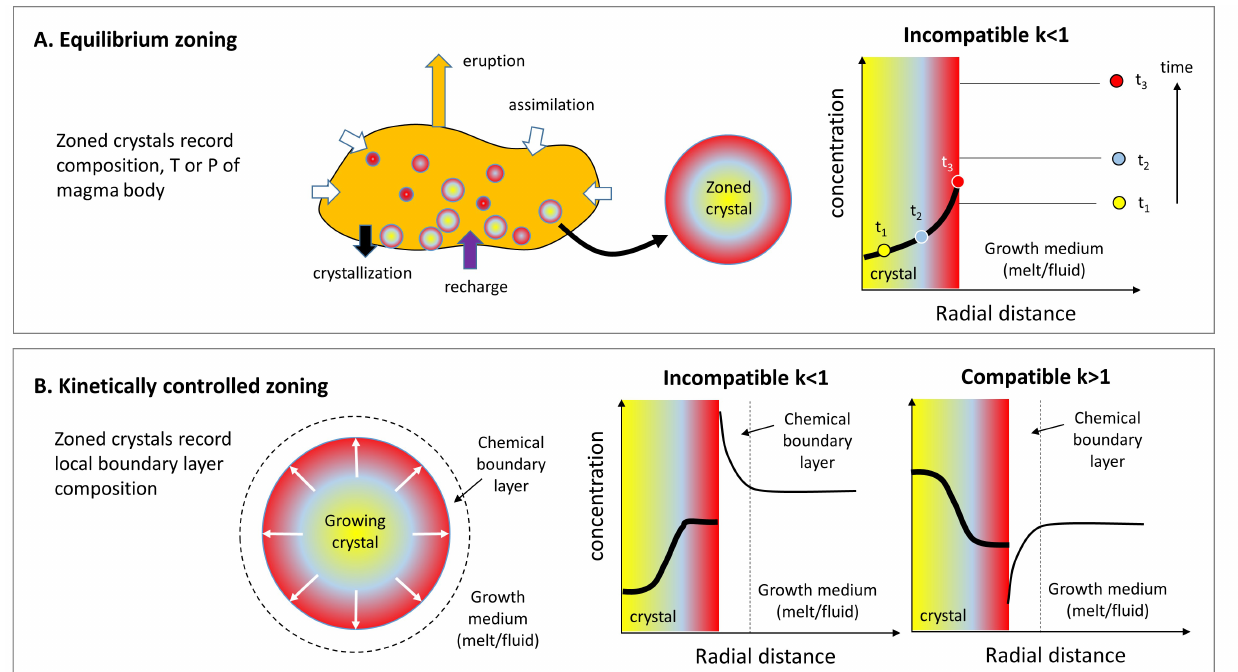
Figure 1: [A] Equilibrium mineral zoning wherein zoning reflects changes in temperature, pressure, or the far-field magma com- position due to fractional crystallization, recharge or mixing. Cartoon magma chamber and zoomed in schematic of a zoned crystal are shown. Right hand plot shows concentration versus radial distance in a crystal for an incompatible element ( k < 1). Left side of plot represents the crystal. Right side represents the melt. Melt is assumed to be well-mixed so melt compositions are spatially constant. Melt composition at different times, t , t , and t are shown. Changes in melt composition with time are 1 2 3 reflected as zoning within the phenocryst. [B] Kinetically limited mineral zoning wherein zoning reflects only the composition of the local boundary layer in the melt, not the far-field melt composition. This is due to rapid growth compared to diffusive transport of a trace element in the melt. Right hand plots show concentration versus radial distance for incompatible ( k < 1) and compatible ( k > 1) elements. Left hand side of each plot represents the crystal. Right hand side represents the melt. For incompatible elements, an enriched boundary layer in the melt develops. The phenocryst begins in equilibrium with the far-field melt composition, but eventually becomes enriched on the rim as the boundary layer develops. For compatible elements, the phenocrysts evolve to being depleted while the melt becomes enriched. Note that in both cases, steady state can eventually be attained. Melt concentration profile represents steady state. Zonation in phenocryst records evolution from initial state to steady state, where radius qualitatively represents